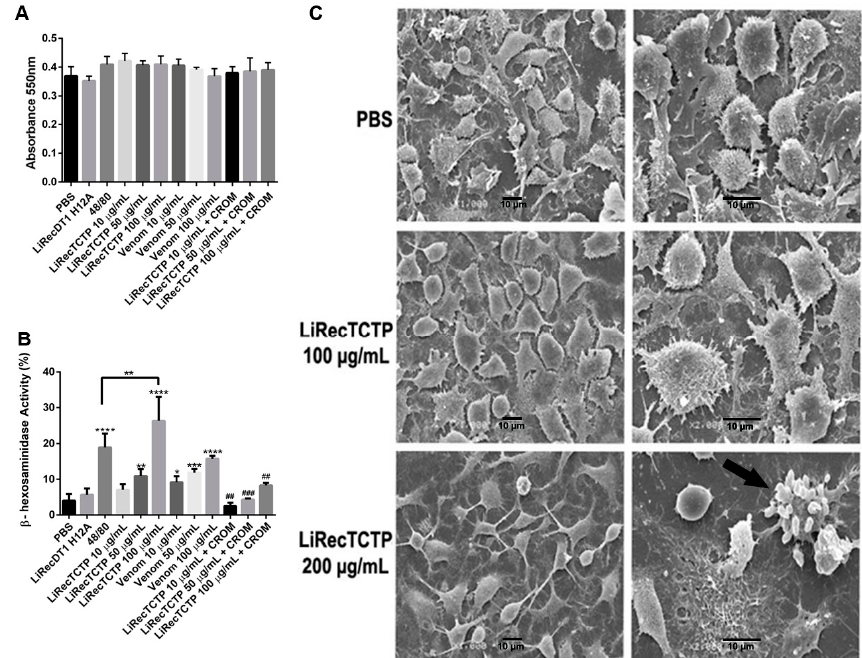
Figure 2. E ff ects of LiRecTCTP in mast cells viability and degranulation in vitro. RBL-2H3 cells (mast-like cells) were incubated with LiRecTCTP (10, 50, and 100 µ g / mL), total venom from L. intermedia (10, 50, and 100 µ g / mL), compound 48 / 80 (100 µ g / mL) (positive control), LiRecDT1 H12A (100 µ g / mL) (negative control) or PBS (negative control). After 2 h viability, morphology and activity of the granular enzyme Beta-hexosaminidase were measured. Inhibition of degranulation was performed using cromolyn (CROM) (20 µ M). ( A ) Cell viability was evaluated using MTT assay. The values represent the average of the three independent experiments ± s.d. (performed in pentaplicate). ( B ) Beta-hexosaminidase activity assay. Results are expressed as the percentage of the total beta-hexosaminidase activity present in the cells, after subtracting the activity in the supernatant of unstimulated cells. The values represent the average of the three independent experiments ± s.d. (performed in pentaplicate) (* p < 0.1; ** p < 0.01; *** p < 0.001 and **** p < 0.0001 compared with control; ## p < 0.01, ### p < 0.001 compared to LiRecTCTP treatment). ( C ) Scanning electron microscopy (SEM) of RBL-2H3 cells after 2 h treatment with LiRecTCTP (100 and 200 µ g / mL). Images of each sample represent di ff erent fields and magnification. Scale bars indicate 10 µ m, magnification 1000 × (left) and 2000 × (right). Arrow: apoptotic